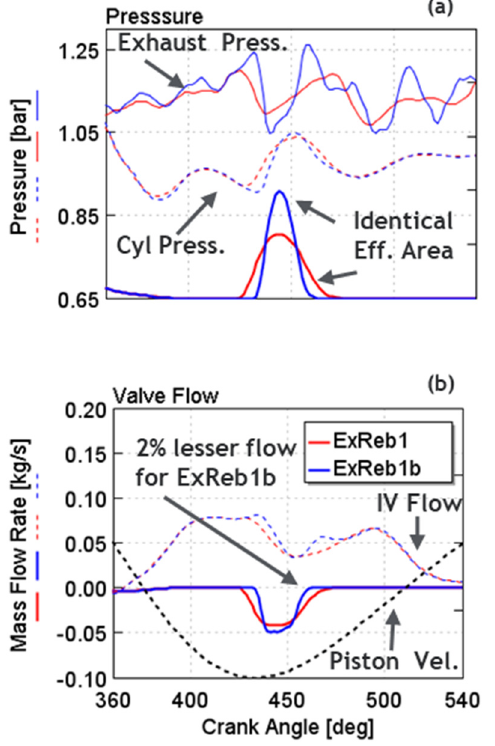
Figure 18. Comparison of ( a ) cylinder and exhaust pressure trends and ( b ) valve flows trends between the ExReb1 and the ExReb1b profiles for Tivc 404 K at B10.